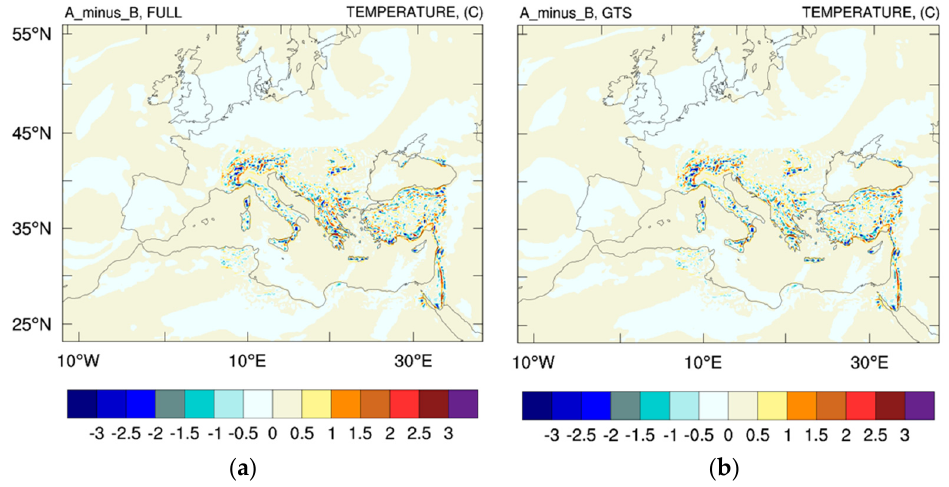
Figure 13. Analysis minus background for the 2 m temperature (°C) at 00 on 18 September 2020 for ( a ) the FULL experiment and ( b ) the GTS experiment.